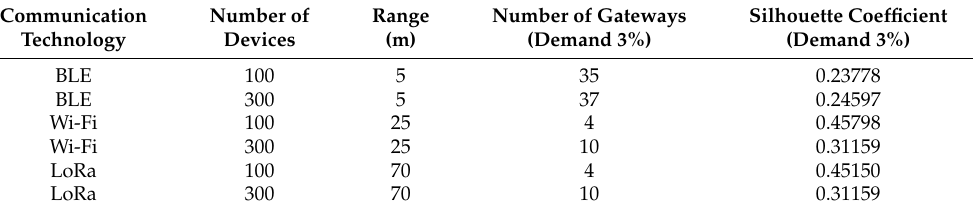
Table 13. The silhouette coefficients after applying the PSO positioning model (simple approach), considering the number of gateways that resulted from the application of the LP model.